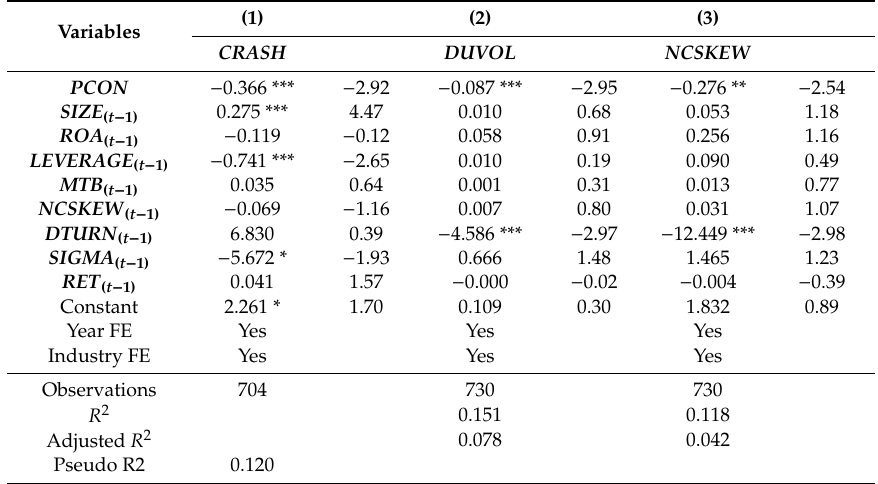
Table 5. Main results: results of regression of political connections on stock price crash risk.